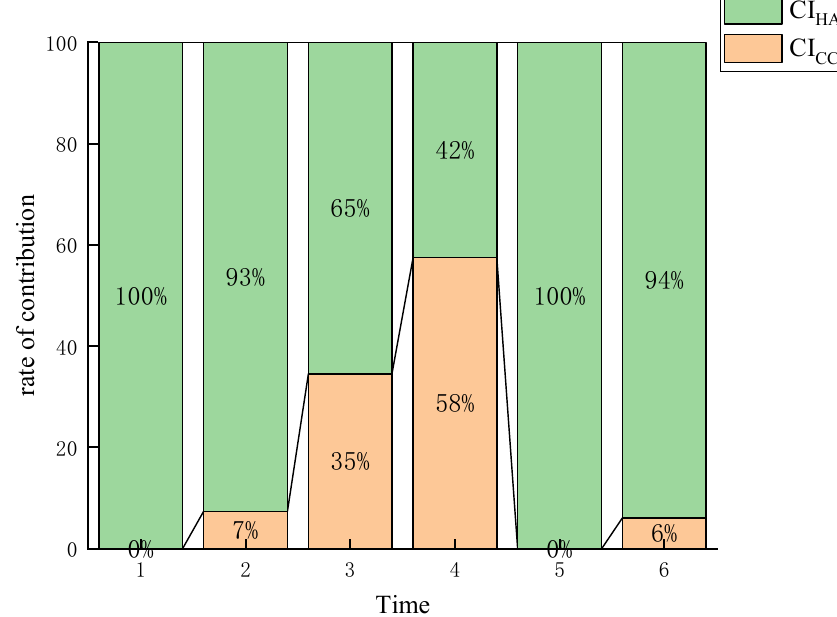
Figure 7. The difference of contribution rate.